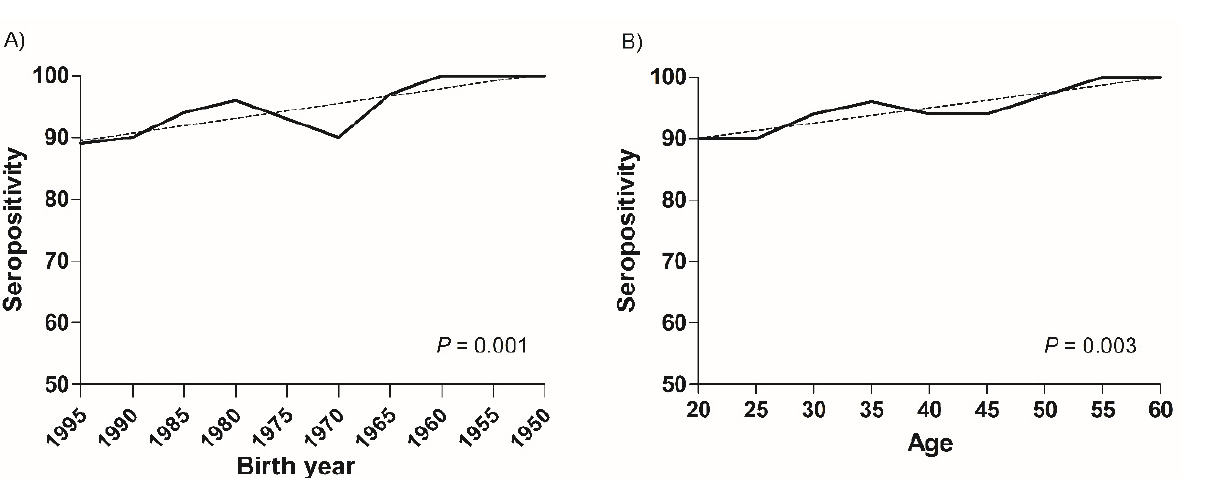
Figure 2. Changes of seroprevalence of measles in healthcare workers according to birth year and age groups. The seroprevalence of measles in healthcare workers decreased according to ( A ) the birth year groups ( p = 0.07) and ( B ) significantly decreased according to the age groups ( p = 0.04). 4. Discussion In this study, the seroprevalence of VZV was 91%. Although the seroprevalence of VZV was above 90% in most age groups, the seroprevalence in the younger age group was lower than 90%. The seroprevalence of VZV significantly decreased with age. More- over, the seroprevalence of measles was 70%, which was lower than 90% in most age groups. The seroprevalence of measles also significantly decreased with younger age. Doctors and nurse assistants had significantly higher seroprevalence than nurses and other HCWs. The incidence of measles has decreased with measles vaccination [6]. However, nos- ocomial measles infections occur in many countries and threaten HCWs and patients, es- pecially those who are immunocompromised [25]. In Korea, measles elimination was de- clared in 2006 with a two-dose measles vaccination, and the vaccination rate was >95%